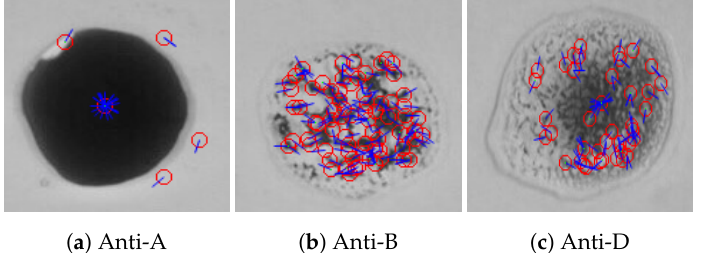
Figure 17. Feature points and their orientation for three blood spots (anti-A, anti-B, and anti-D) of an example of a blood sample using the SIFT